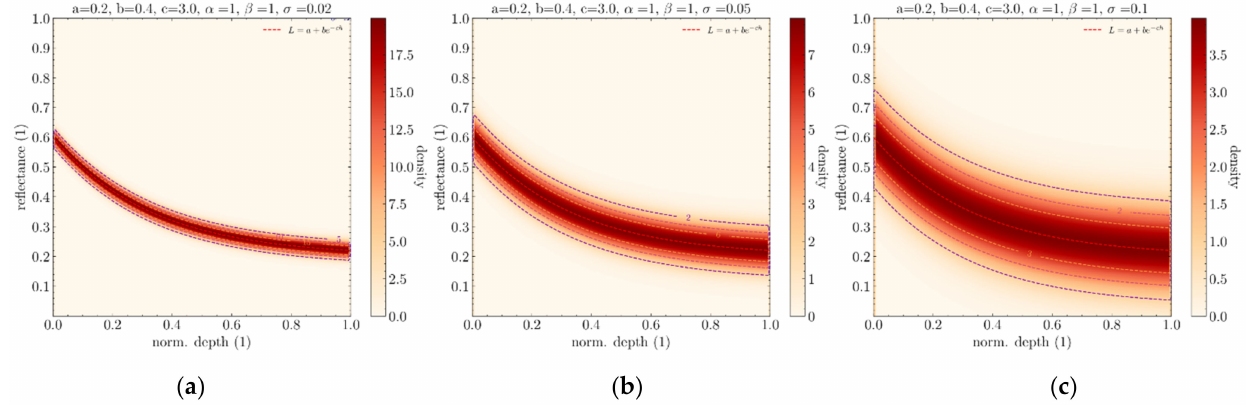
Figure 11. Influence of the σ dispersion parameter. ( a ) low σ . ( b ) average σ . ( c ) High σ .